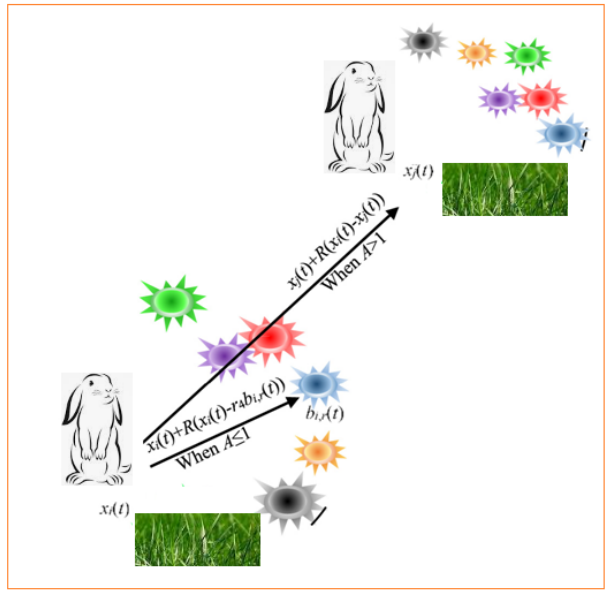
Figure 2. Search structure according to factor A.